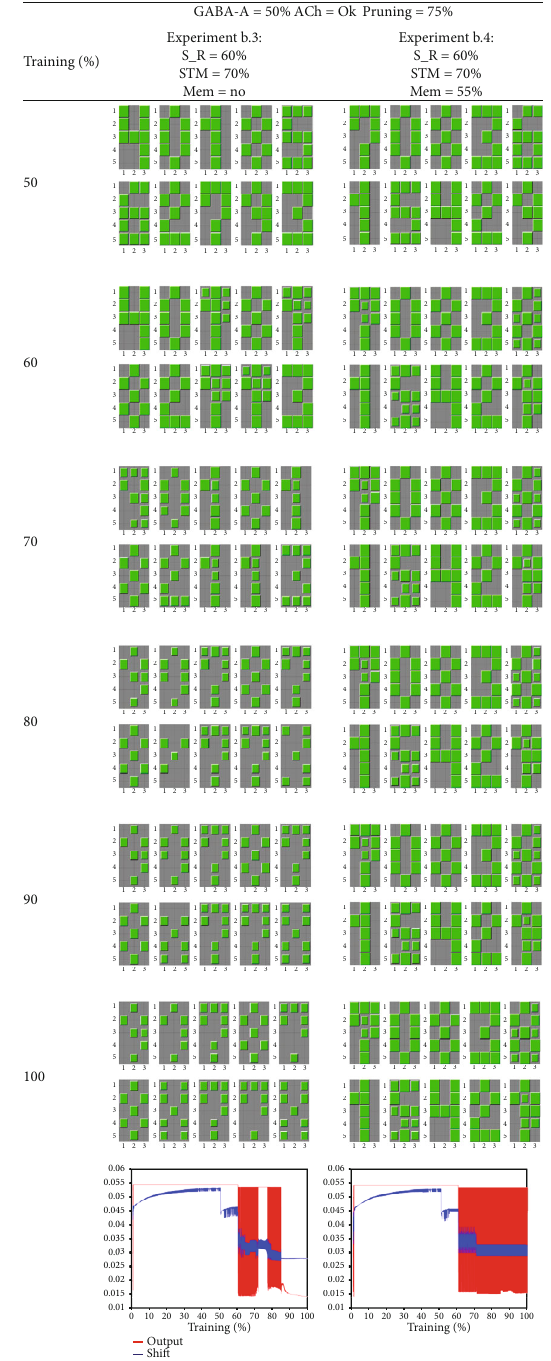
Figure 8: This table shows the koniocortex model behavior when the reduction of sensory stimuli takes place after a reduction in GABA-A. A short-term memory (STM) learning task is shown in the fi rst and second columns, consisting of learning an “ X ” pattern in substitution of one of the numerical patterns that constitute the learning set. In the second column, we evaluate the usage of NMDA blockers like memantine. At the bottom of each column, we show the evolution of all neurons ’ average output (in red) and average shift (in blue). Experiment b.3: the pattern “ X ” presented at 70% of repetitions is successfully learned. Despite this apparent success, the univocal correspondence between patterns and neurons that were compromised at 60% of epochs did not return to normal. Notice that episodes of oscillation and stabilization are intermingled and that learning a new pattern stabilizes the network, although this stable situation is usually transitory. In experiment b.4, the administration of an NMDA blocker like memantine took place at 55% of epochs. Numerical pattern memories are kept intact, but, when introducing pattern “ X ” at 70% of repetitions, the network was incapable of learning it. Stimulus reduction at 60% in a GABA-A-depleted network contributed to the initiation of persistent oscillations. Labels: S_R=sensory reduction; STM =short-term memory; Mem =memantine; ACh =acetylcholine reduction in thalamocortical